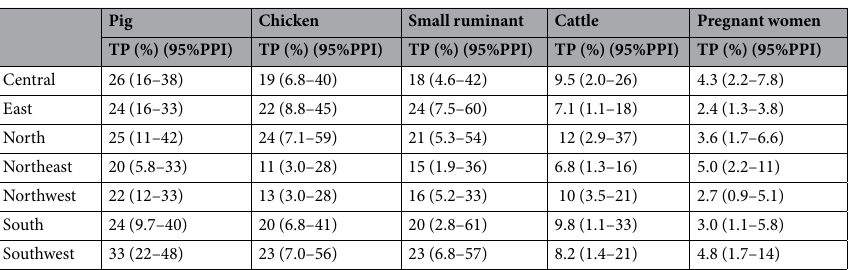
Table 4. Bayesian hierarchical model estimates for T. gondii true seroprevalence (%) in pregnant women and livestock in mainland China, by region. TP: true seroprevalence; PPI: posterior probability